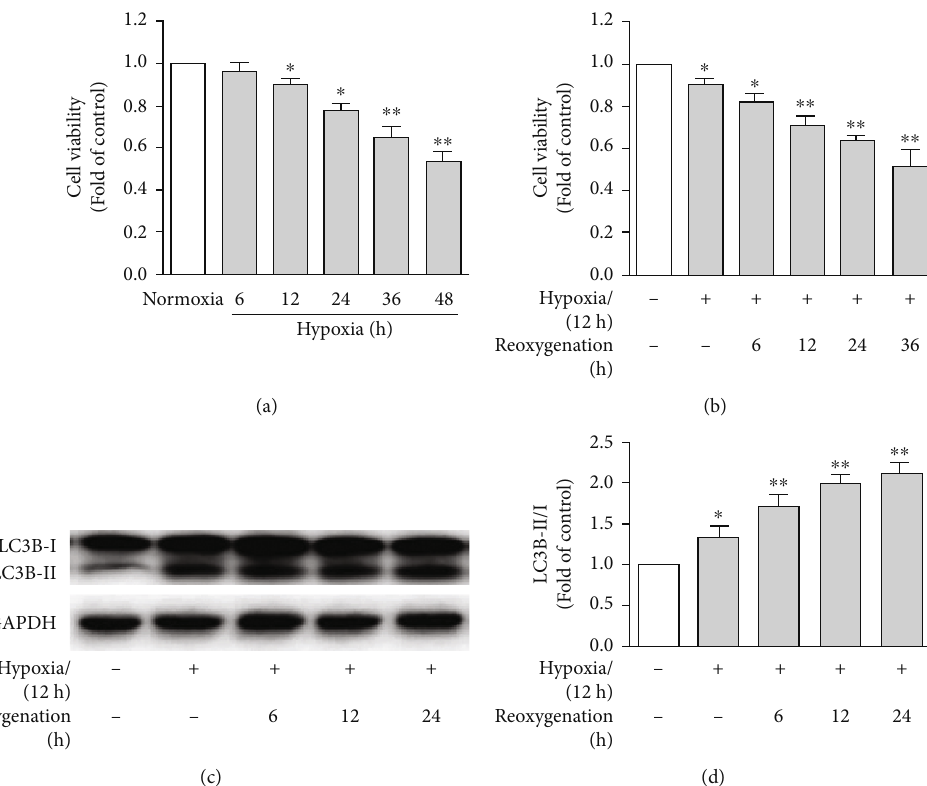
Figure 1: Hypoxia/reoxygenation reduces cell viability and increases autophagy in neonate rat cardiomyocytes. Neonate rat cardiomyocytes were cultured in normoxia (control), hypoxia condition for 6-48 hours alone, or followed by reoxygenation for 6-24 hours. Cell viability was measured by MTT assay (a, b; n = 6 ), or cell lysates were subjected to Western blotting analysis to detect autophagy (c, d; n = 4 ). All data on cell viability or autophagy formation in hypoxia or hypoxia/reoxygenation are calculated as the fold changes relative to normoxia culture (control) and presented as mean and standard error of mean. (a) Cell viability measured following normoxia or hypoxia culture. (b) Cell viability measured following normoxia culture, hypoxia alone (12 hours), or hypoxia followed by reoxygenation for 6-36 hours. (c) Representative Western blotting images for LC3B-I, LC3B-II, and GAPDH in cardiomyocytes cultured at normoxia condition, hypoxia alone for 12 hours, or followed by reoxygenation for 6-24 hours. (d) Quanti fi cation of autophagy formation in cardiomyocytes in indicated culture conditions by the ratio of LC3B-I to LC3B-II. ∗ P < 0 : 05 and ∗∗ P < 0 : 01 , one-way (a) or two-way (c, d) ANOVA followed by comparison with normoxia culture condition